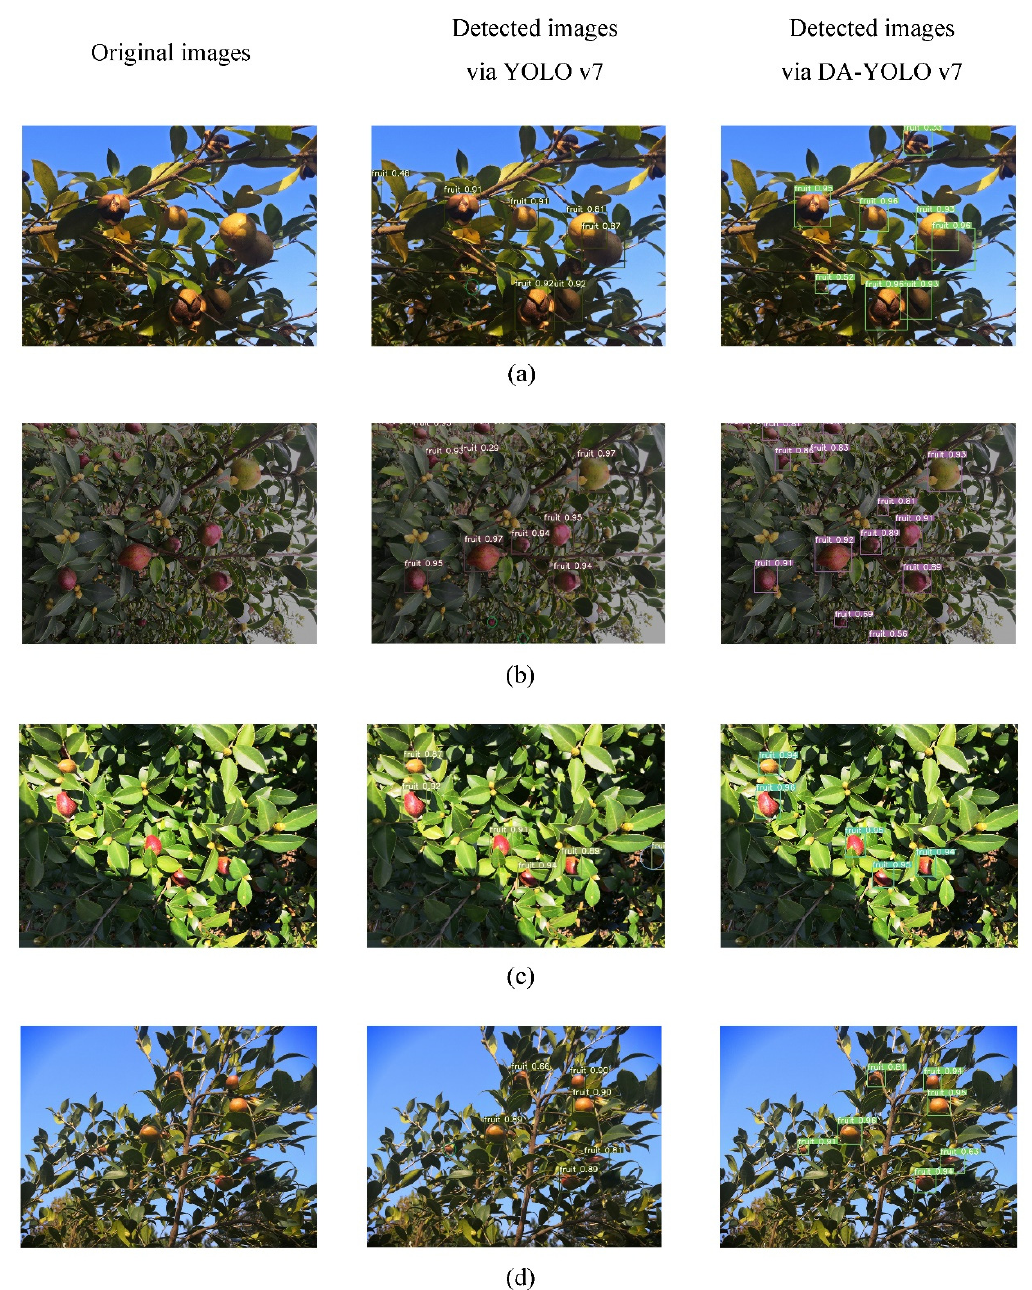
Figure 10. Examples of the detection results between YOLOv7and the DA-YOLOv7models. ( a ) side- light angle; ( b ) backlight angle; ( c ) Slight occlusion; ( d ) Heavy occlusion.